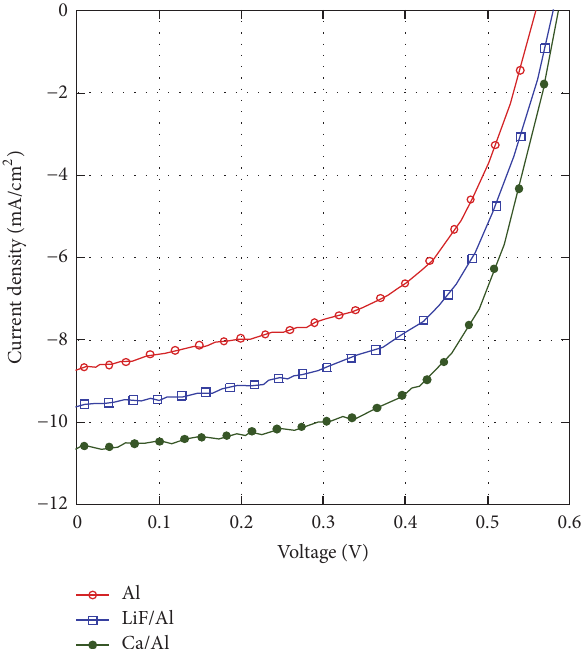
Figure 4: J-V characteristics of the devices with different CILs, measured under 100mW/cm 2 illumination (AM 1.5G). Devices are based on ITO/PEDOT:PSS/P3HT:PC 70 BM (200 nm)/CILs/Al (with no thermal